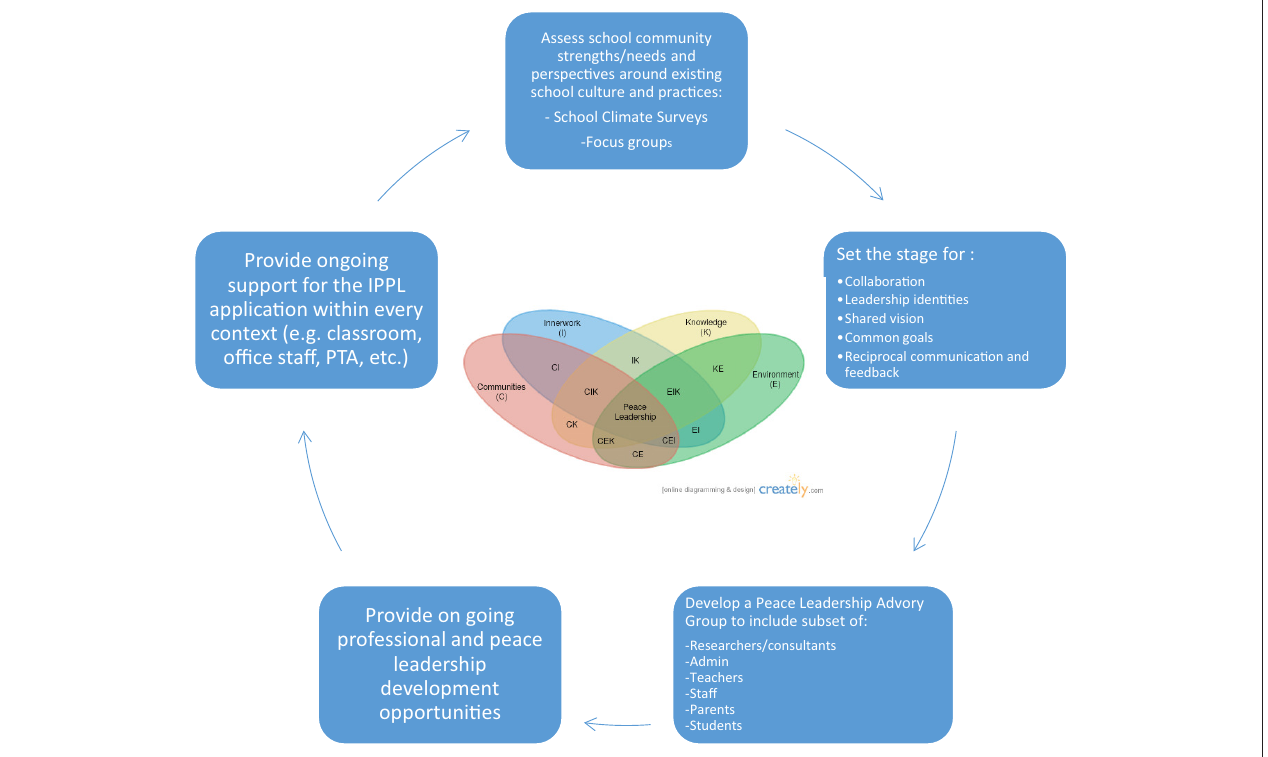
FIGURE 4 | The Integral Perspective of Peace Leadership school implementation cycle.